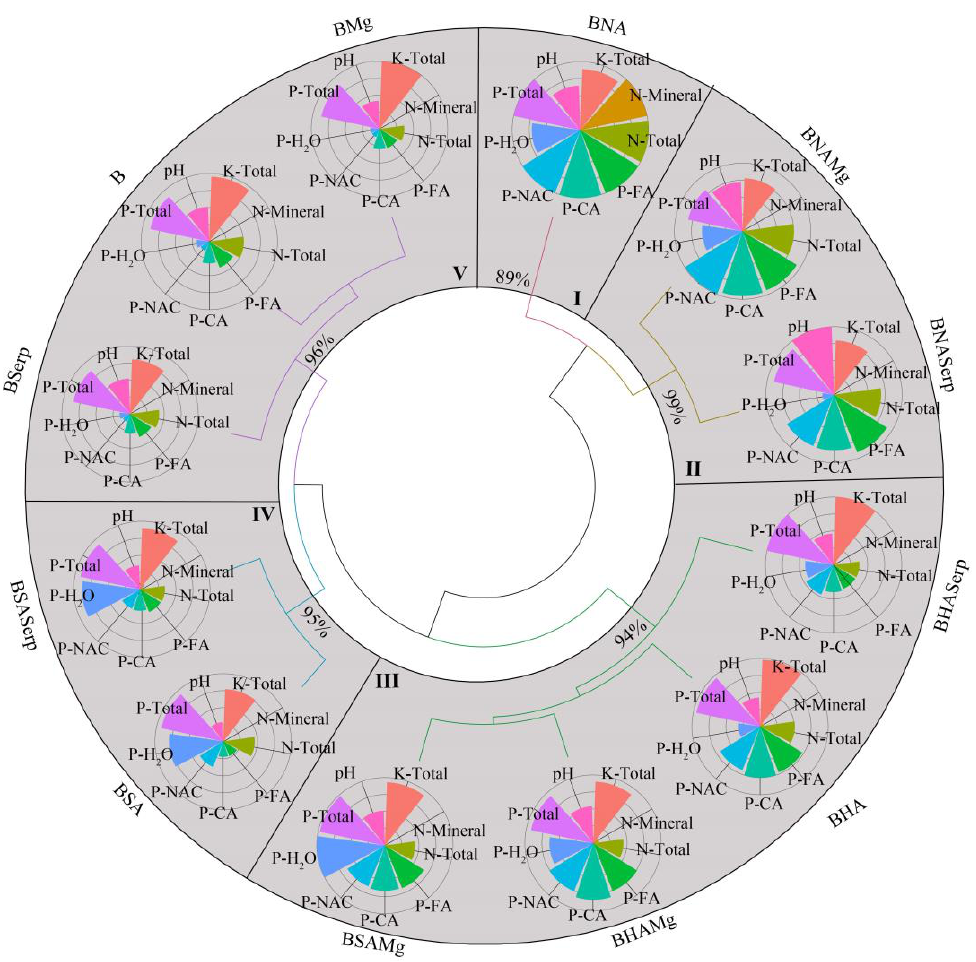
Figure 1. Clustering of biochar-based fertilizers (BBFs) synthetized based on their main properties. Percentage means the similarity within each group formed as an output of the cluster analysis. K-Total: total concentration of potassium; N-Mineral and N-Total: concentration of N-mineral and N-total; P-FA, P-CA, P-NAC, and P-H 2 O: the concentration of P soluble in formic acid at 2%, in citric acid at 2%, in neutral ammonium citrate plus water, and water respectively; P-Total: total concentration of P. The charts at the tip of terminal branches of the diagram display the ratio of each variable in each biochar in relation to the maximum value of the same variable found in one of all BBFs. For each variable measured, the rescaled values varied from 0 to 1 (maximum value across all samples). More details of the BBFs acronyms are shown in Table